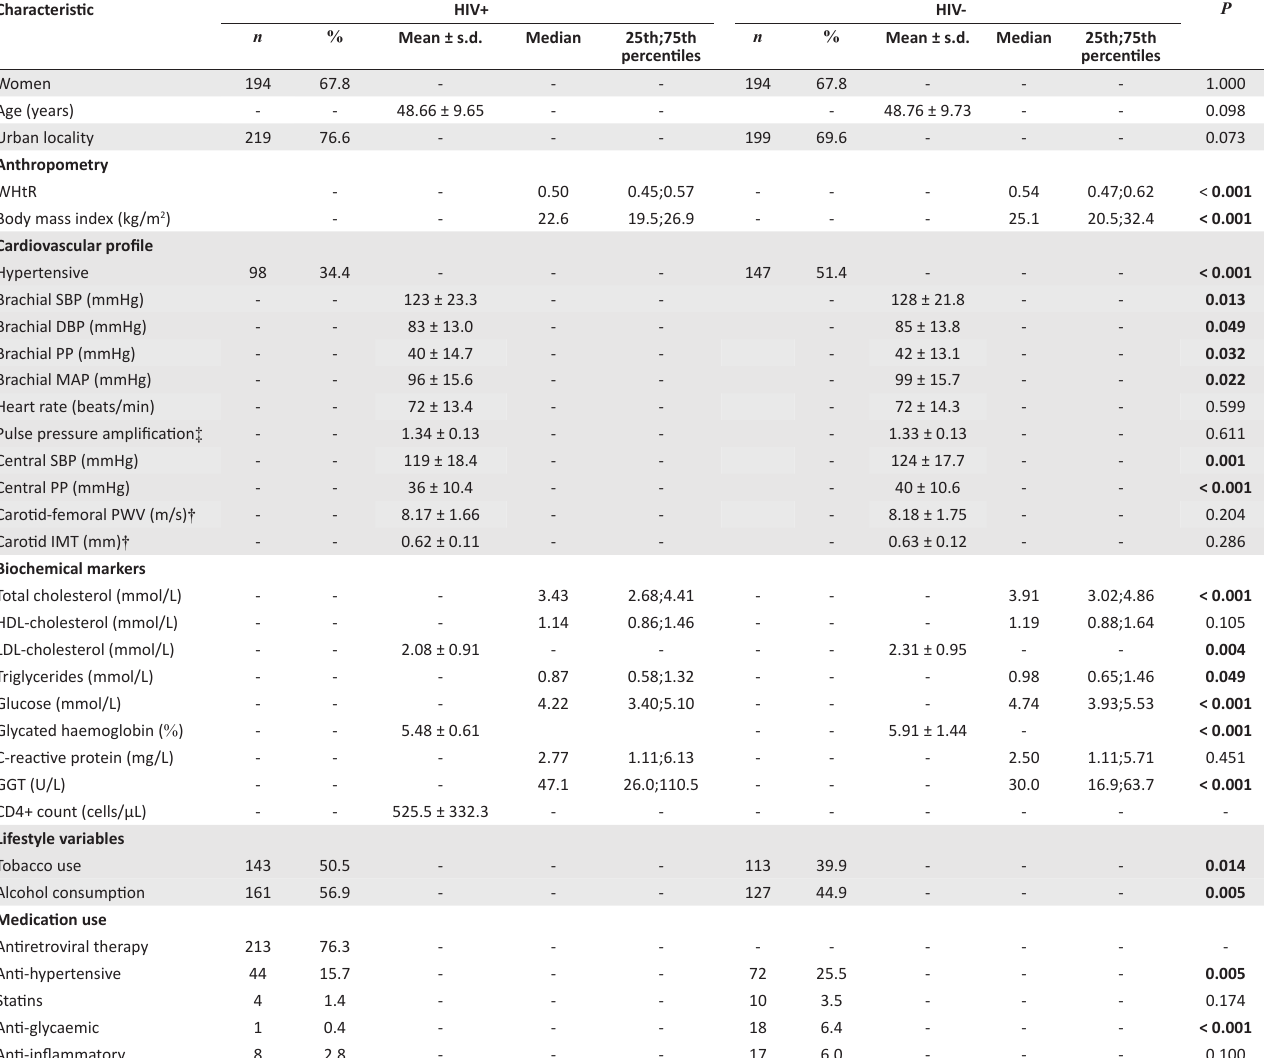
TABLE 1: Characteristics of the study population ( N = 286).